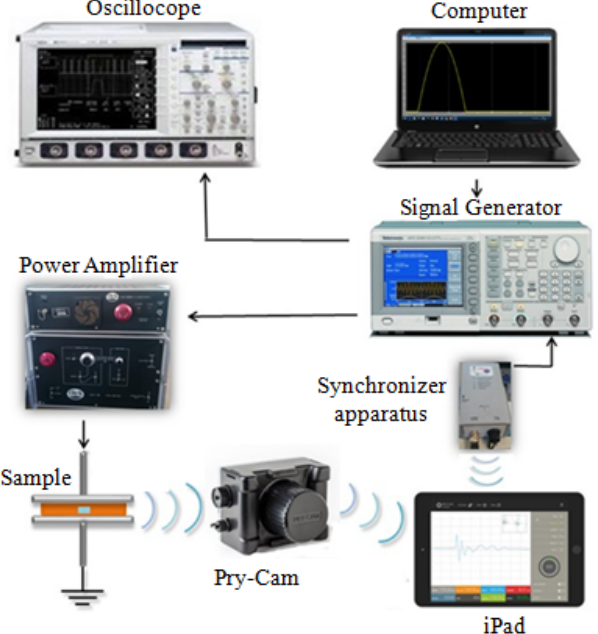
Figure 2. Laboratory setup for the generation of DCP waveforms and acquisition of PD patterns.